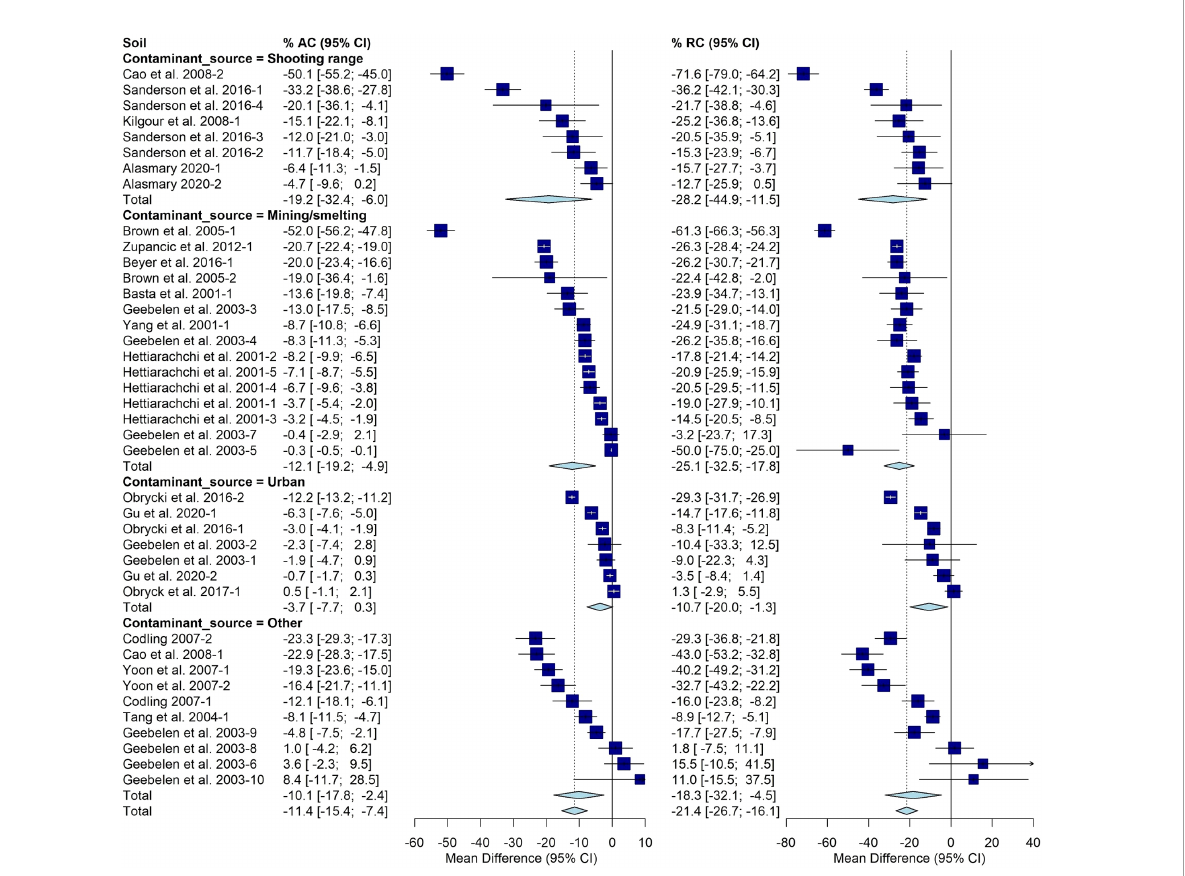
FIGURE 3 Fully random effects forest plot for AC and RC grouped by contaminant source. Squares represent the mean difference for a soil and error bars are 95% CI. Diamonds represent the 95% CI of the mean difference between the control and treated soil for each subgroup and the overall treatment